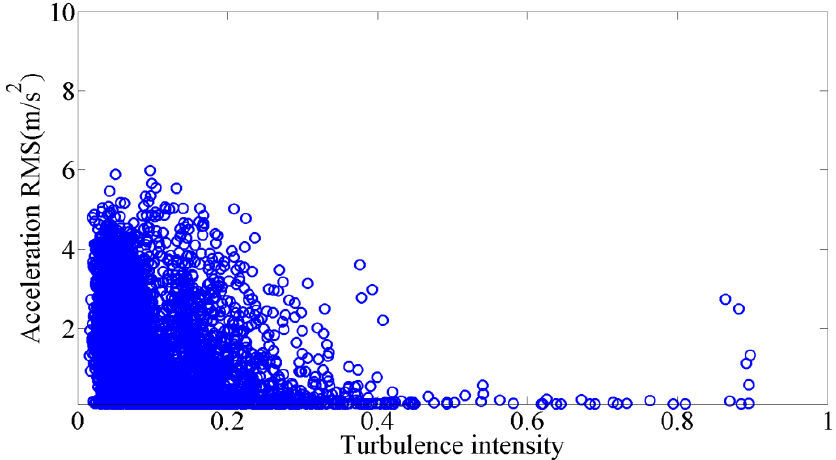
Figure 13. Vibration amplitude versus turbulence intensity in April.